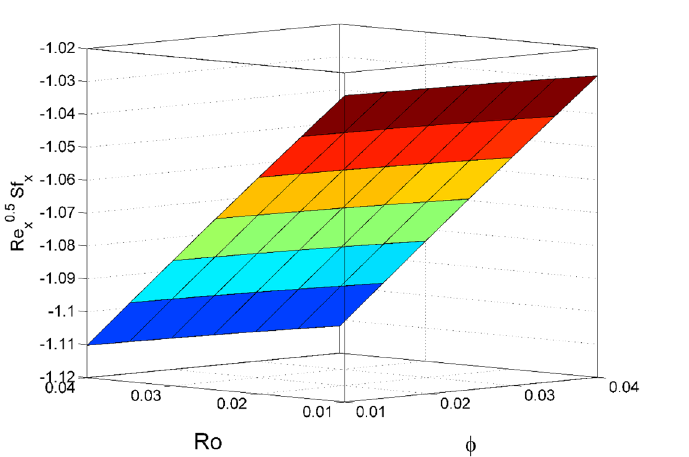
Figure 15. Effect of φ on �(ζ) .